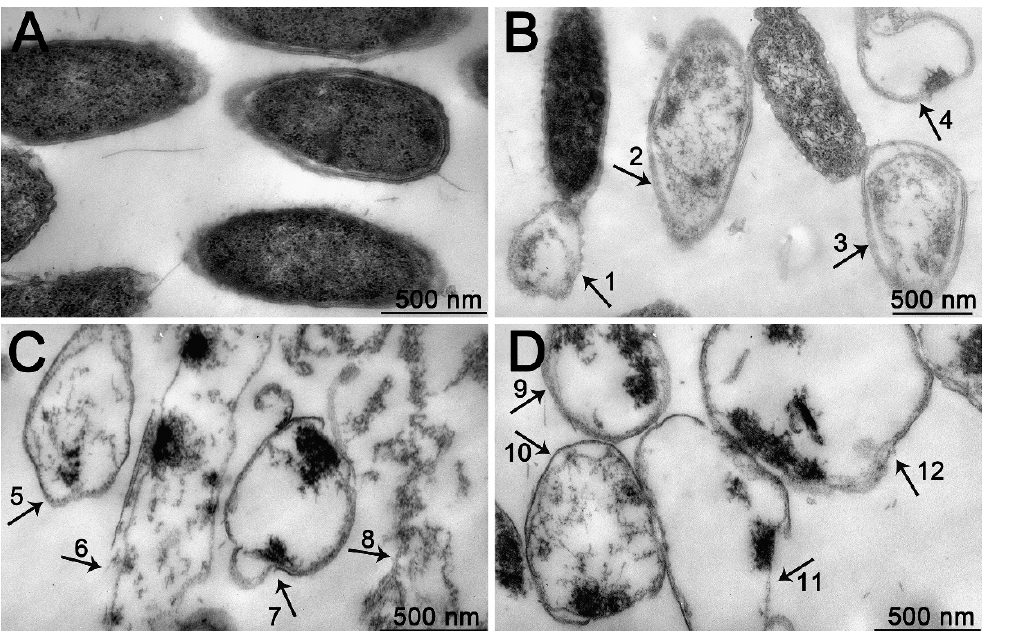
Figure 6. Transmission electron micrographs of Pectobacterium carotovorum subsp. carotovorum (Pcc) treated with 2% DMSO (control; ( A ): 80,000 ×) and 5 mg/mL of Polygonum orientale essential oil (( B ): 60,000 ×, ( C ): 80,000 ×, ( D ): 80,000 ×). Pcc cells displayed vacuoles (1, 4, 5, 9, 10, 11 and 12), and some showed plasmolysis (2 and 3). Some Pcc cells formed long strips (6) and cyclic shapes (7). Plentiful cell fragments appeared in some Pcc cells (8).